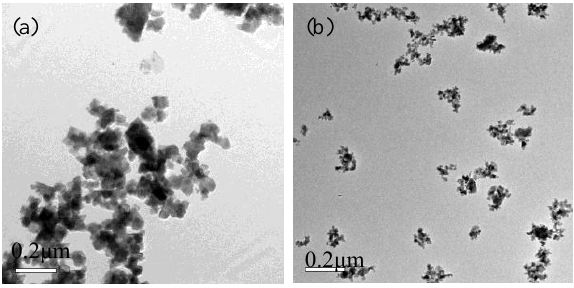
Figure 1: FT-IR spectra of nano-Sb 2 O 3 and the experimental materi- als